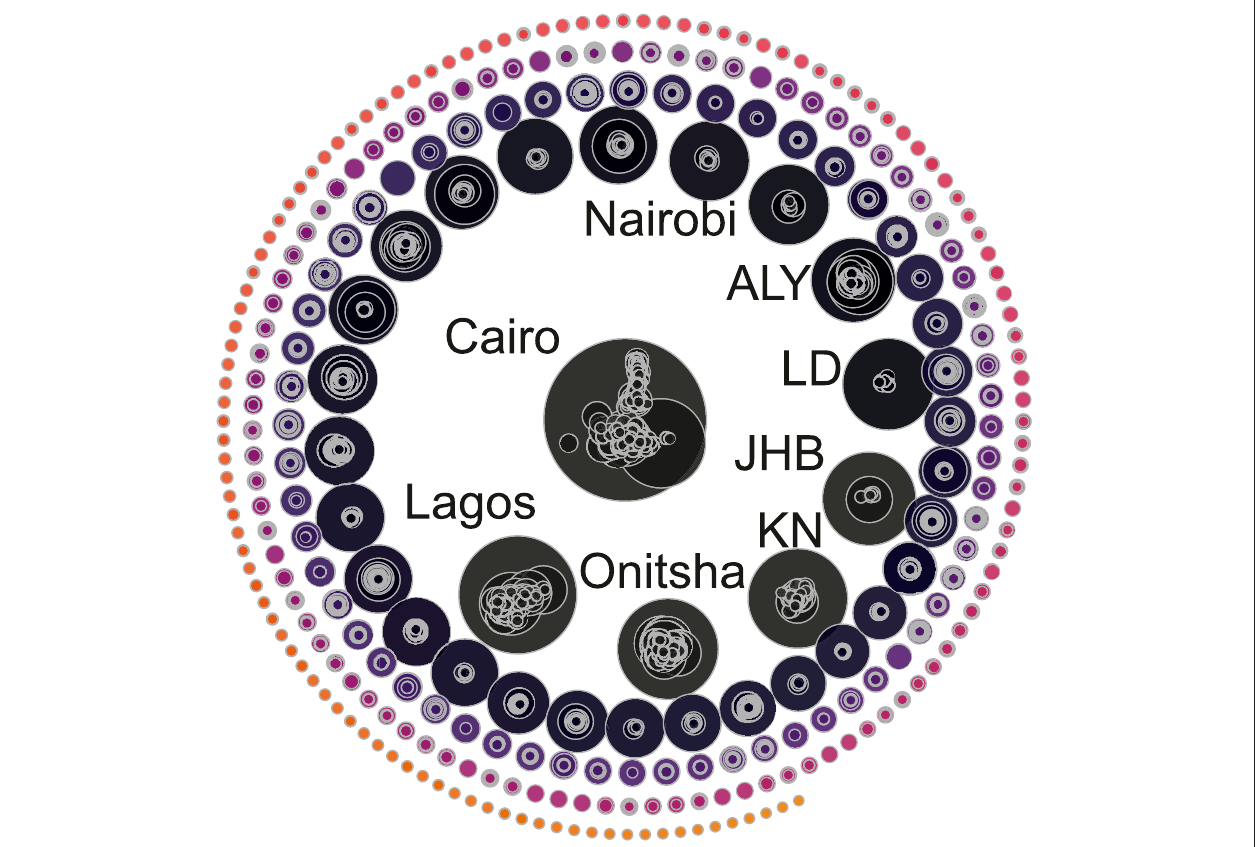
FIGURE 3 | The result of considering δ = 255 km. The procedure gives M = 288 regions of in fl uence. The largest region of in fl uence has 246 cities and 57 million inhabitants,withCairoatits centre.The largestcentresareCairo,Lagos,Onitsha,Kinshasa,Johannesburg, Luanda, Alexandriaand Nairobi. With δ =255 km,there are 84 regions of in fl uence with a single